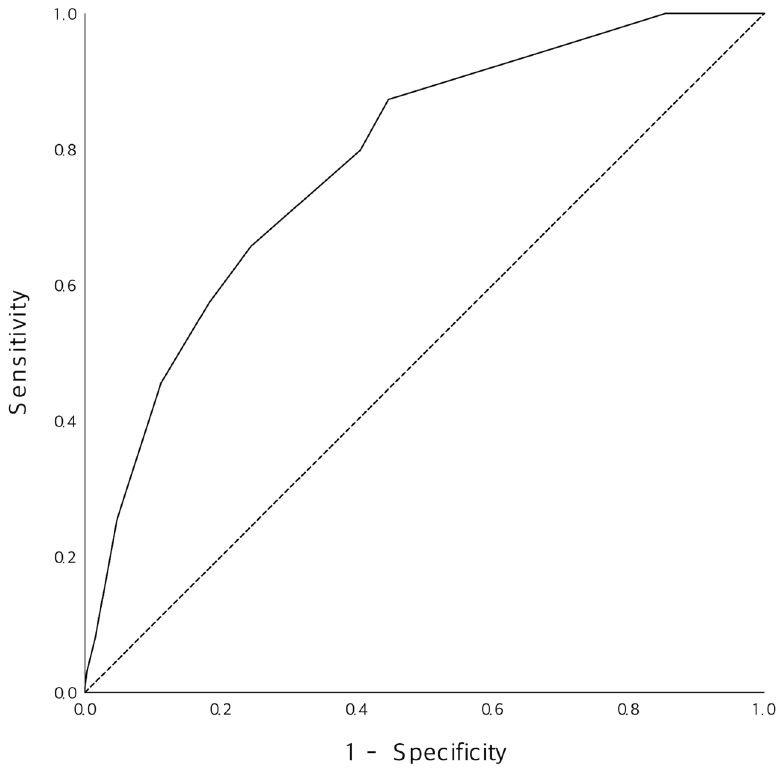
Figure 3. Comparison of the predictive ability of the new score with that of the development and validation set. Table 3. Diagnostic performance in predicting the significant stenosis in the validation set.